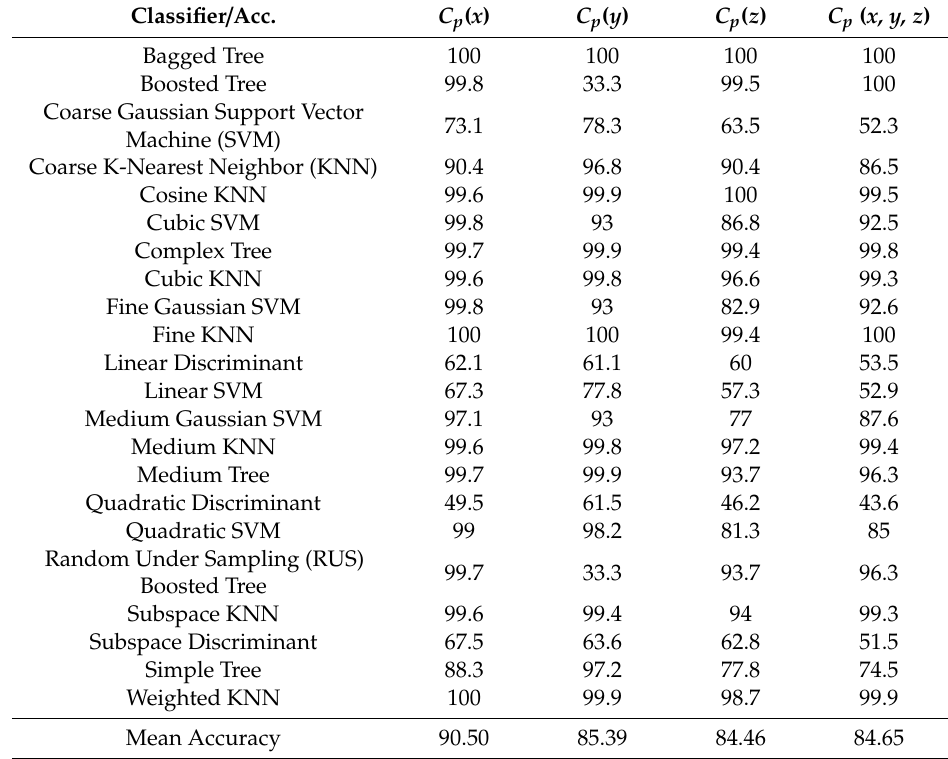
Table 3. Classification performance among single coordinate position and the xyz position. This accuracy is obtained for a window size of